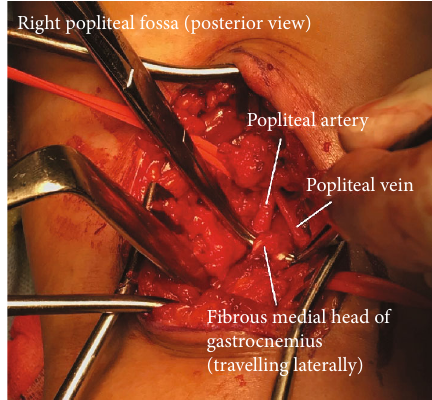
Figure 3: Intraoperative posterior approach of the right popliteal fossa, demonstrating the culprit fi brous muscular band of the medial head of the